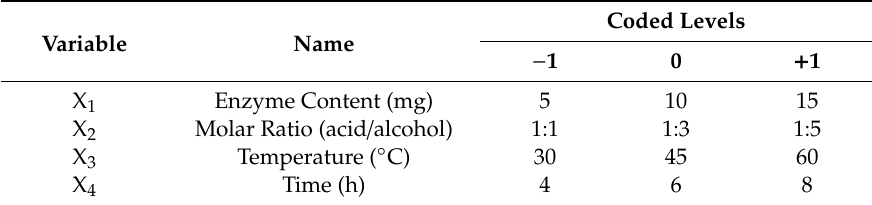
Table 4. Variables and their levels for the